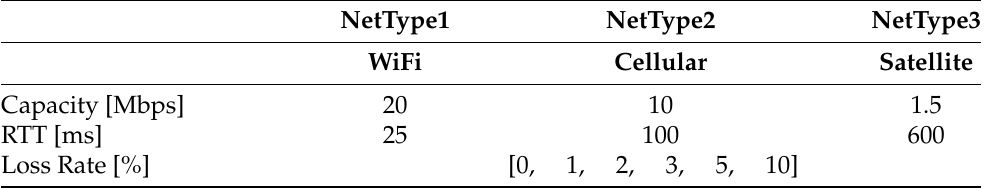
Figure 4. Scenario A. Three Linux containers running different MQTT roles. From left to right: publisher client, broker server, and subscriber client. The broker is connected to each client over a P2P link, which emulates different wireless access technologies. Table 1. Network parameter ranges for different wireless